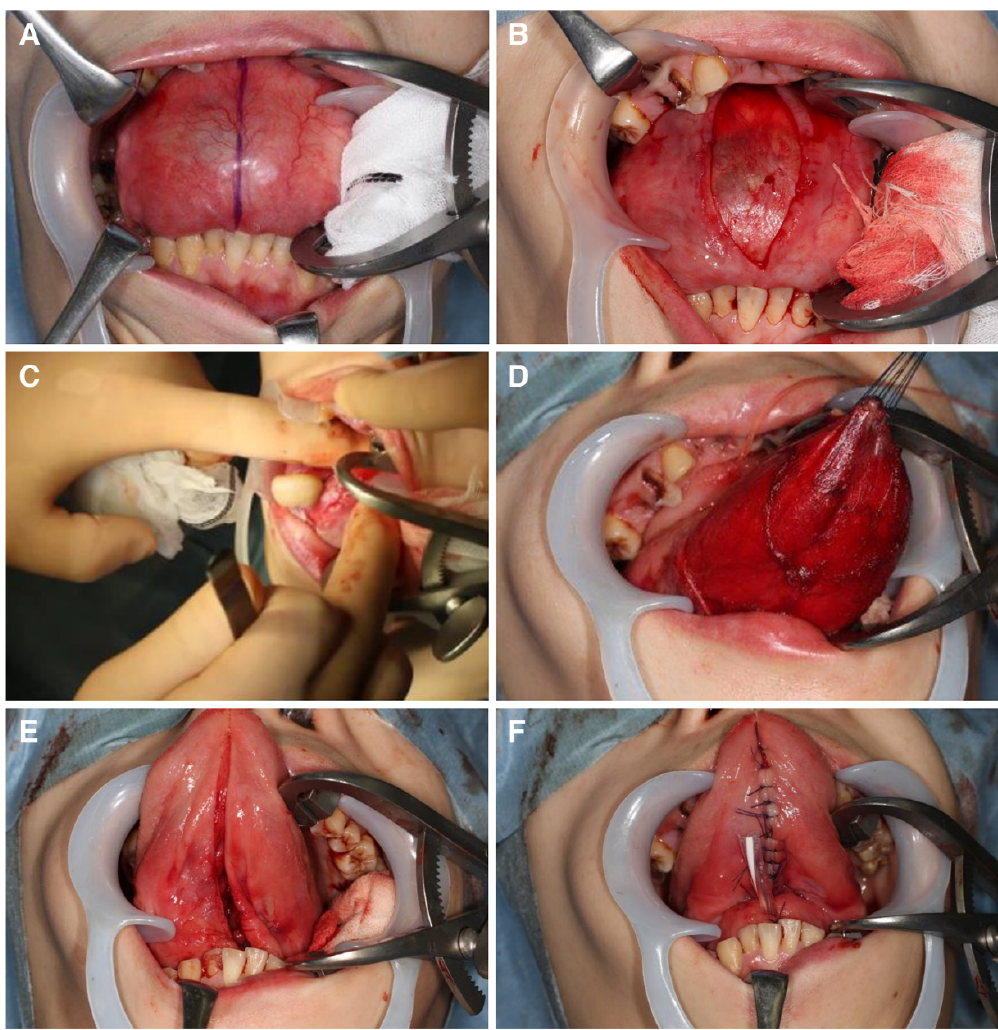
Figure 4. Intraoperative images. The cyst was reduced in size by removing contents to obtain a field of view and the necessary space to perform the surgery. ( A , B ) A 15 mm incision made in cyst wall. ( C ) Milky-white contents removed. ( D ) Posterior detachment while pulling. ( E , F ) Wound closed and a Penrose drain placed.